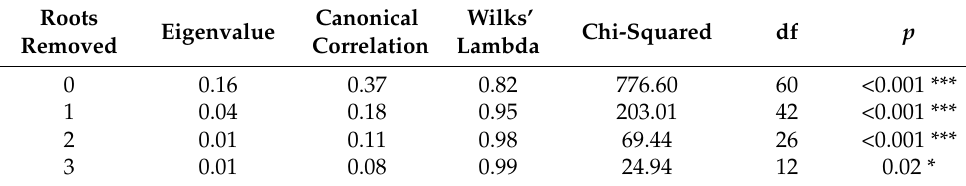
Table 1. Discriminant Analysis